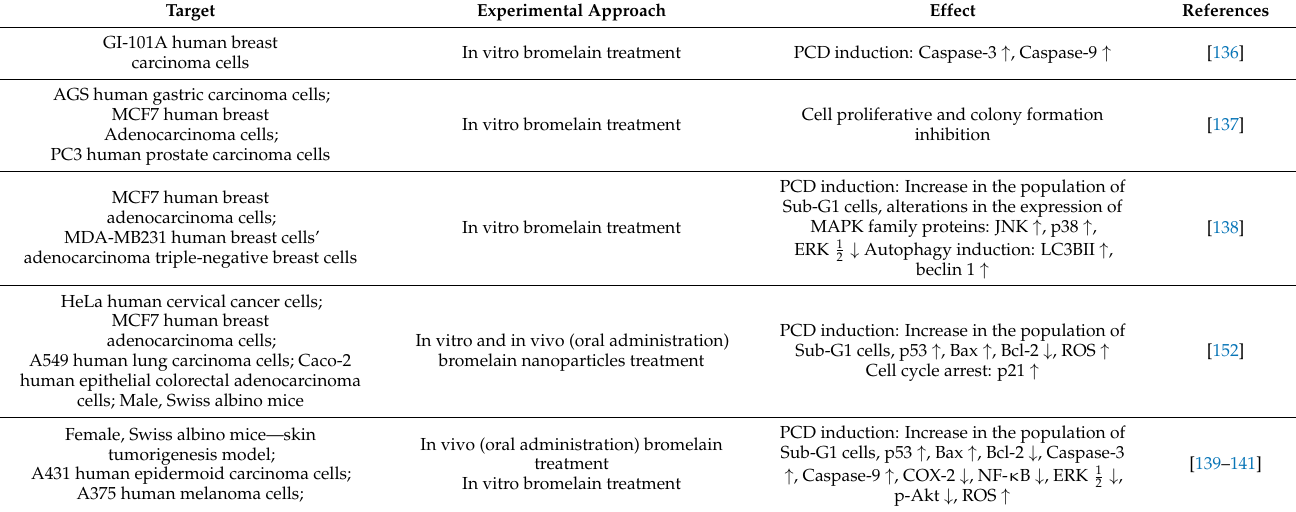
Table 2. Cellular and molecular targets of bromelain related to its anticancer